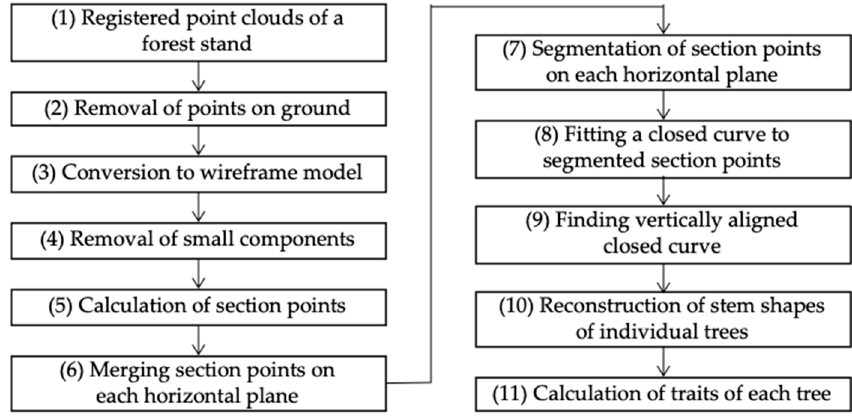
Figure 3. Process outline.